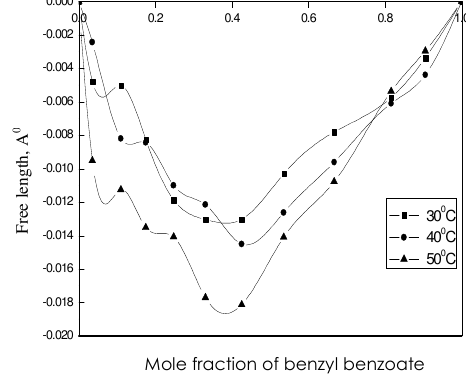
Figure 2 (b) - Variation of excess free length with mole fraction of benzyl benzoate in Mole fraction of benzyl benzoate Mole fraction of benzyl benzoate Figure 2a. Variation of excess Figure 2b. Variation of excess free length compressibility with mole fraction of with mole fraction of benzyl benzoate in the benzyl benzoate in the mixture benzyl mixture benzyl benzoate + benzoate + benzonitrile